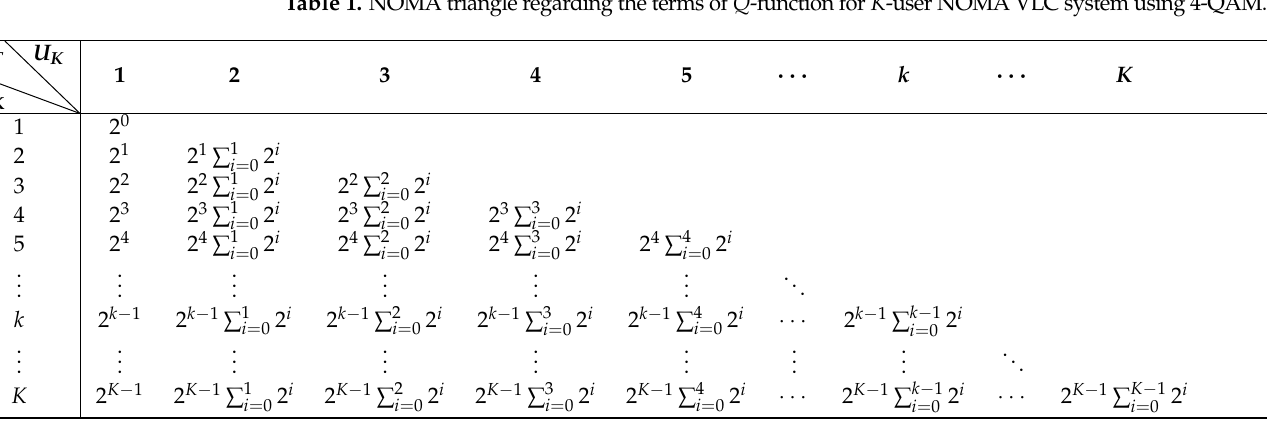
Table 1. NOMA triangle regarding the terms of Q -function for K -user NOMA VLC system using